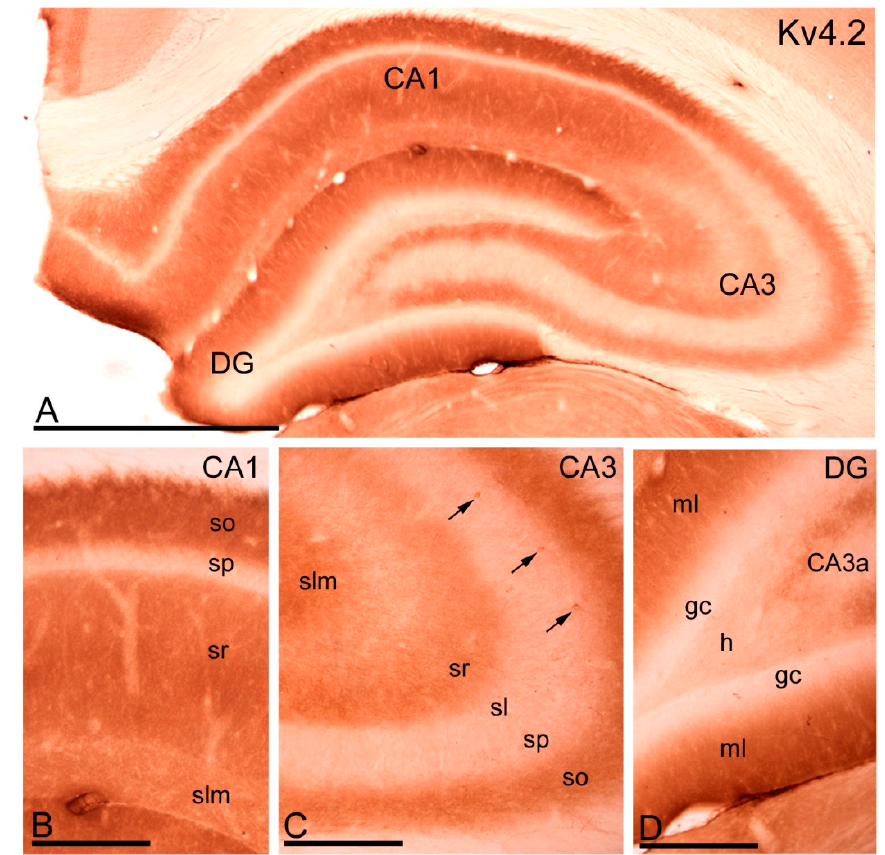
Figure 5. Distribution of immunoreactivity for Kv4.2 in the hippocampus. ( A ) At the light microscopic level, immunoreactivity for Kv4.2 was widely distributed in the hippocampus but its intensity varied consistently; ( B ) In the CA1 region, immunolabelling for Kv4.2 was generally moderate-to-strong, with the strata oriens (so) and radiatum (sr) showing the highest and the stratum lacunosum-moleculare (slm) showing weak immunoreactivity. The weakest immunolabelling for Kv4.2 was observed in the stratum pyramidale (sp); ( C ) In the CA3 region, moderate immunolabelling for Kv4.2 was observed in the strata oriens (so), radiatum (sr) and stratum lacunosum-moleculare (slm), weak in the stratum lucidum and very weak in the stratum pyramidale (sp). Kv4.2 immunolabelling was also seen outlining somata and dendrites of scattered interneurons (arrows); ( D ) In the dentate gyrus (DG), immunolabelling was strong in the molecular layer (ml), weak in the hilus (h) and the weakest in the granule cell layer (gc). Scale bars: A , 500 µm; B – D , 150 µm.